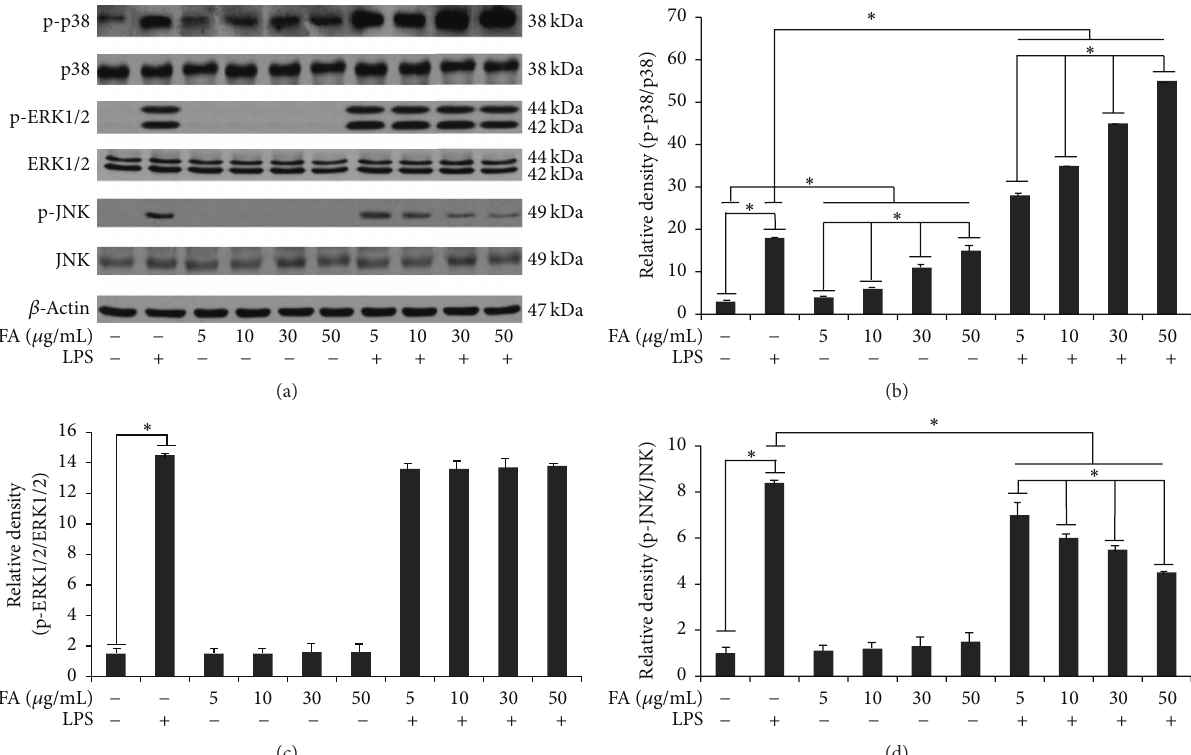
Figure 4: Signaling pathways evoked by LPS-activated BV-2 cells in folic acid-treated cells. Cells were treated with the indicated doses of folic acid (5, 10, 30, and 50 𝜇 g/mL) for 1h before 12h LPS (1 𝜇 g/mL) treatment. (a) Total cell lysates were prepared for a western blot analysis of the content of p-38 protein, p-ERK 1/2, and p-JNK in BV-2 cells. Protein levels were determined by measuring immunoblot band intensities by scanning densitometry: (b) p38 and p-p38; (c) ERK 1/2 p-ERK 1/2; (d) JNK and p-JNK. Data represent the means ± S.D. of five separate experiments. ∗ 𝑝 < 0.05 .